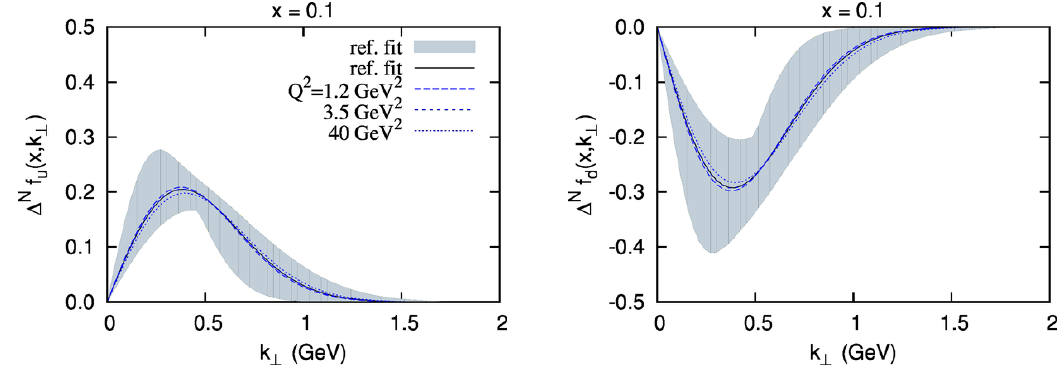
Figure 13 . Extracted Sivers distributions for u = u v + (cid:22) u (left panel) and d = d v + (cid:22) d (right panel). The central line of our reference (cid:12)t (solid black), is compared the Sivers function, extracted with the modi(cid:12)ed model according to eq. (5.1), at a (cid:12)xed value of x = 0 : 1 (blue lines), for three values of Q 2 : 1 : 2 GeV 2 (long-dashed), 3 : 5 GeV 2 (short-dashed) and 40 GeV 2 (dotted). For comparison, we show the error bands corresponding to the reference (cid:12)t with no Q 2